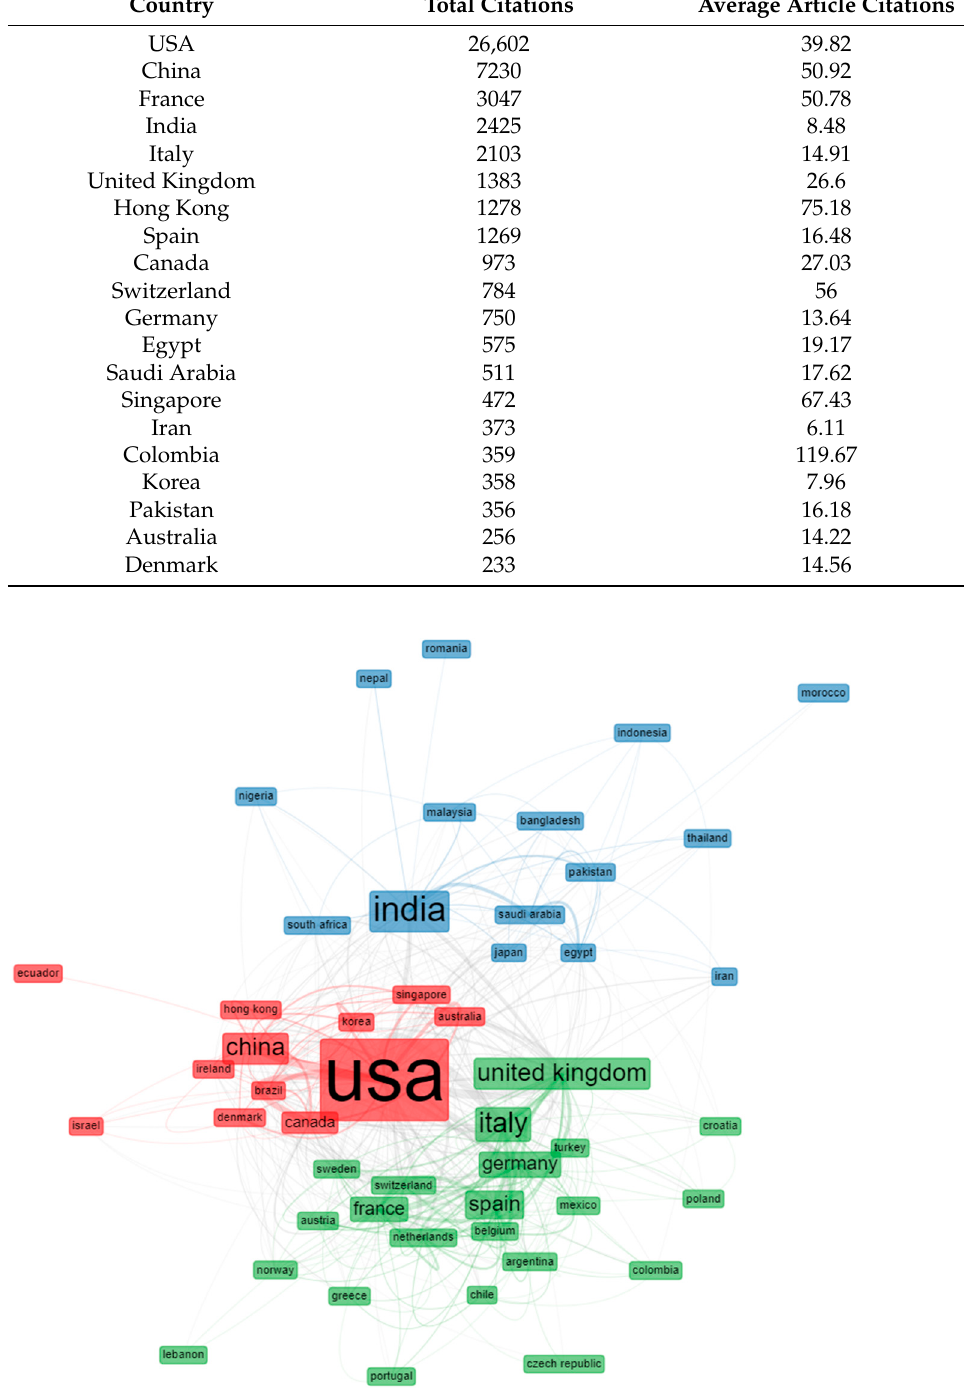
Figure 6. Visualization of collaborative network by countries.